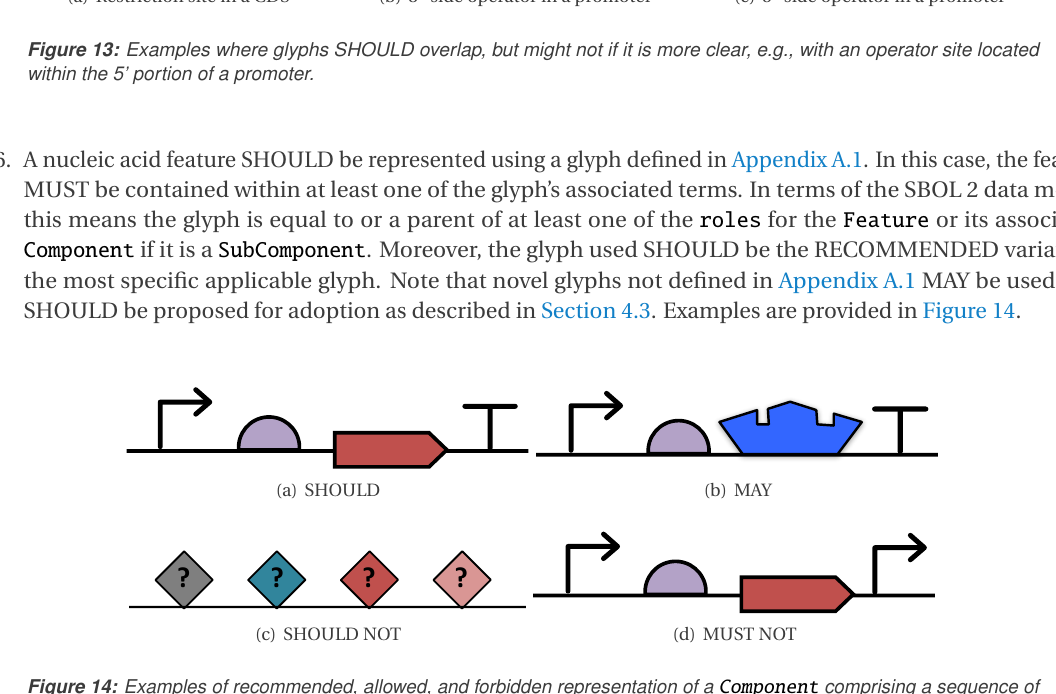
Section 5 SBOL Visual Diagram